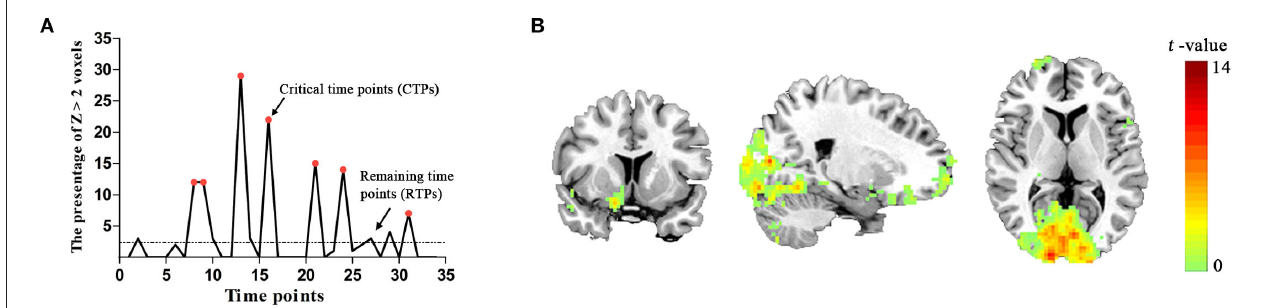
FIGURE 2 | (A) The spontaneous brain activity pattern from a participant. The ordinate shows the percentage of Z > 2 voxels across the 34 time points. The red points indicate the critical time points (CTPs), and the rest were remaining time points (RTPs). (B) Schematic representation of the brain regions representing significant associations with spontaneous activity in the PVA [ p < 0.05, cluster size > 50 voxels, corrected False Discovery Rate (FDR)].